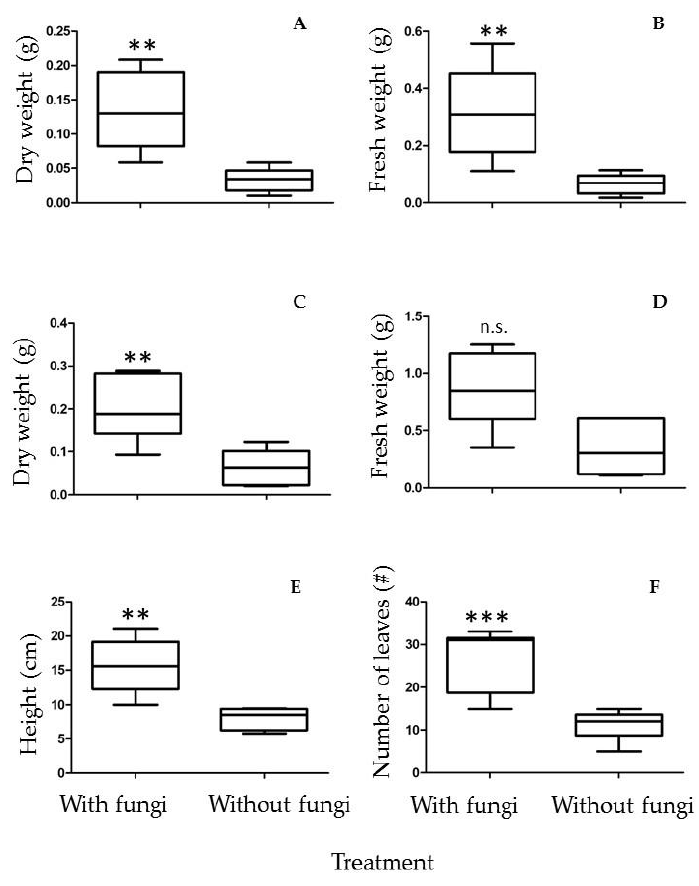
Figure 6. Plant growth-promoting activity of A. luchuensis C7 on P. laevigata plants grown on control substrate. ( A ) Leaf dry weight, ( B ) Leaf fresh weight, ( C ) Root dry weight, ( D ) Root fresh weight, ( E ) Plant height, ( F ) Number of leaves. n.s. = no significant difference, ** p < 0.01; *** p < 0.001.